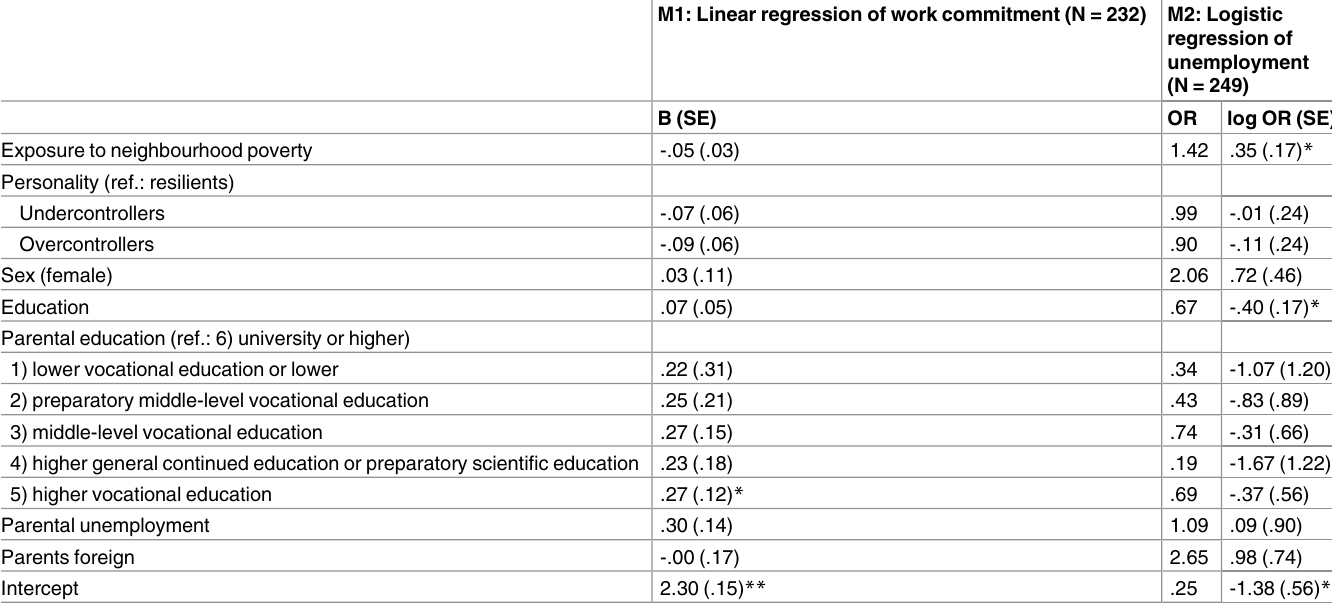
Table 2. Models predicting early adulthood work commitment and unemployment.